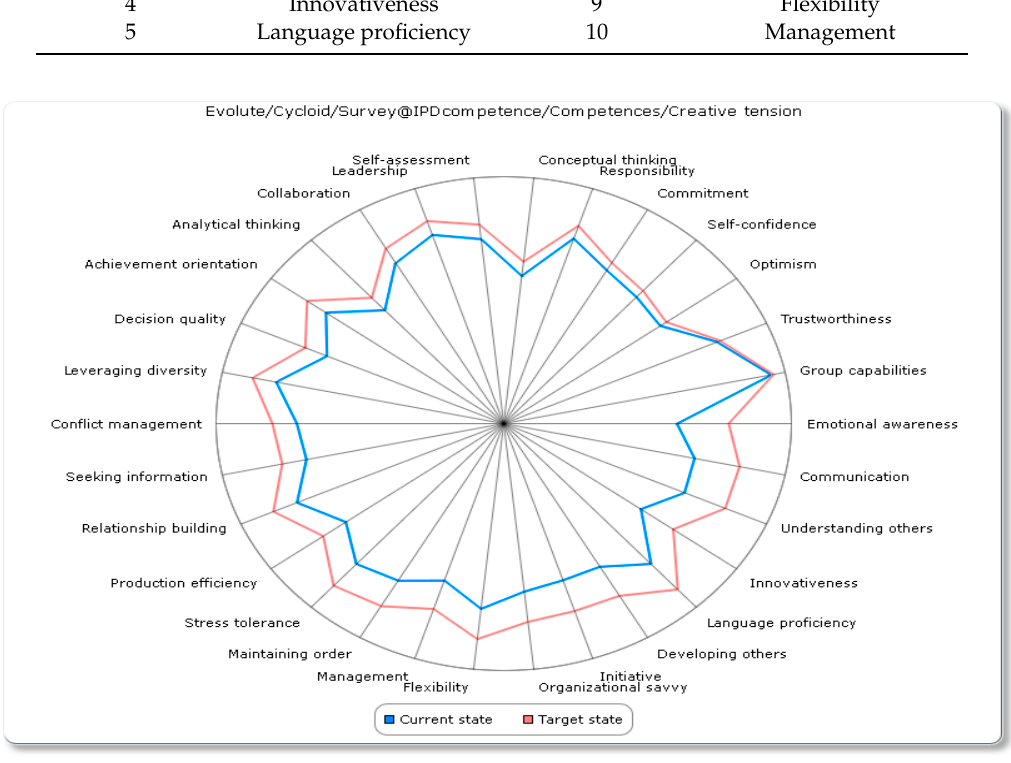
Figure 6. Project managers’ willingness to improve their competencies (creative tension).